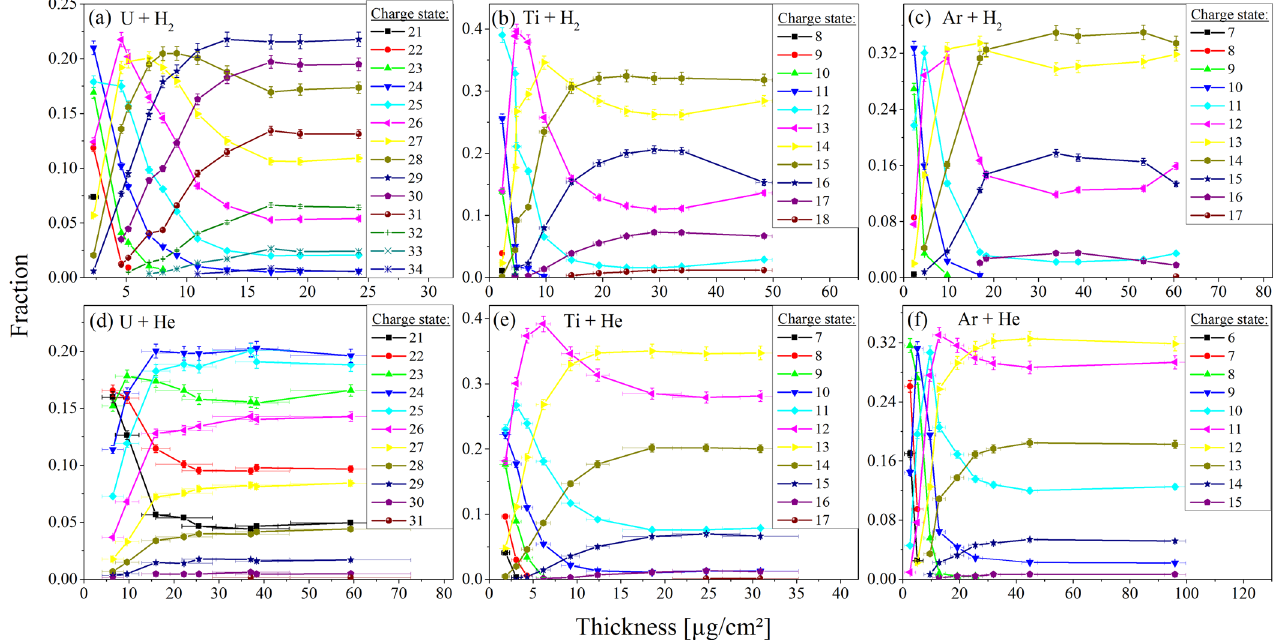
FIG. 6. Measured charge state fractions for 238 U, 50 Ti, and 40 Ar at 1 . 4 MeV = u on H 2 and He gas for increasing target thicknesses, corresponding to the charge state distributions shown in Fig. 5.